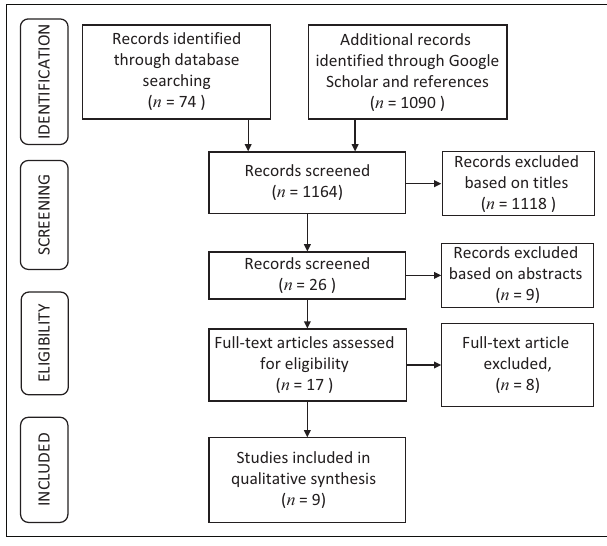
FIGURE 1: Flow diagram for the systematic review of mindful awareness practices programmes for children aged 3–10, 2005–2015.